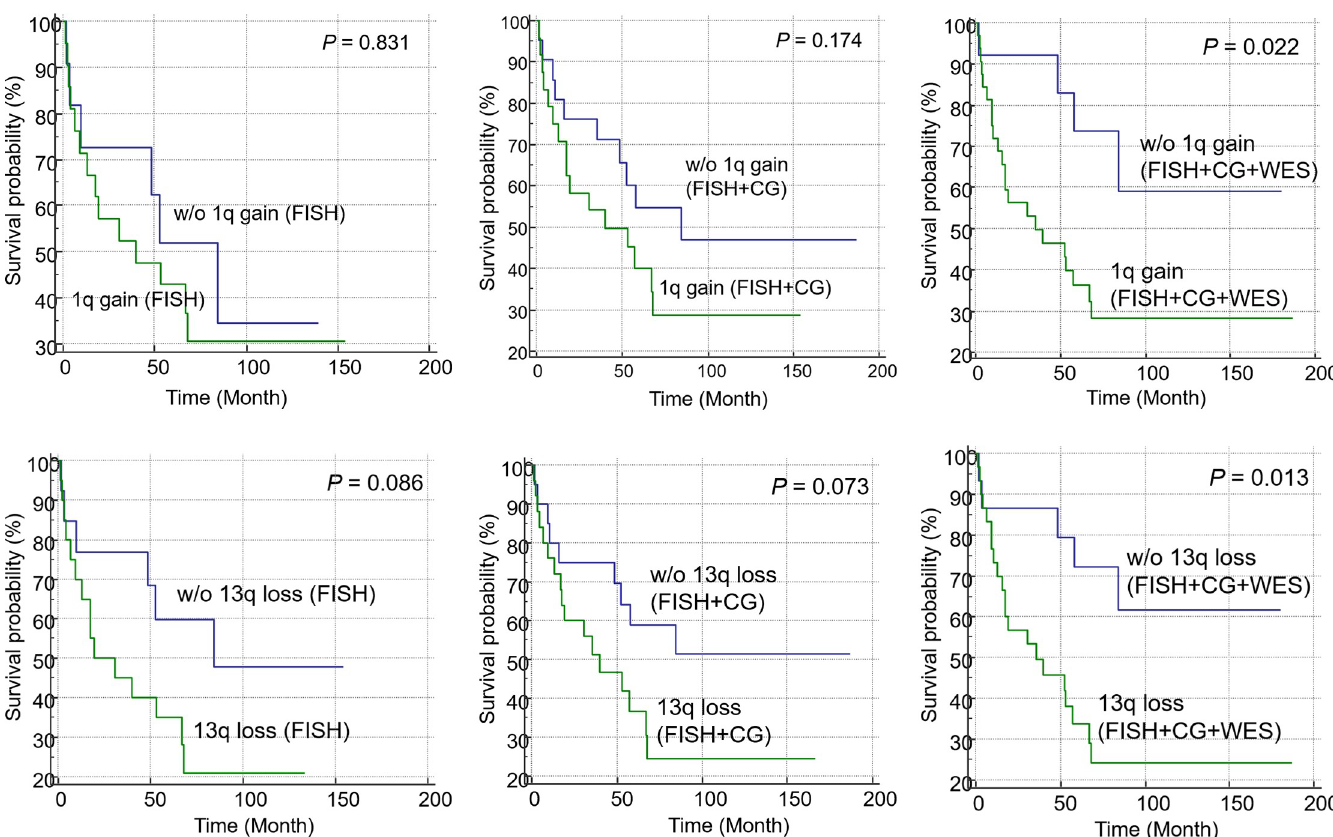
Fig 6. Kaplan-Meier survival curves of patients with copy number variations identified using Fluorescent in Situ Hybridization (FISH), conventional cytogenetics (CG), and Whole-Exome Sequencing (WES) analysis. Overall survival (OS) of patients with 1q gain identified through FISH+CG+WES analysis was significantly poor (C). However, the OS of patients with 1q gain identified through FISH (A) or FISH+CG (B) was not significantly different. Similarly, the OS of patients with 13q loss identified through FISH (D) and FISH+CG (E) was not significantly different. However, patients with 13q loss identified through FISH+CG+WES analysis exhibited significantly poor prognosis